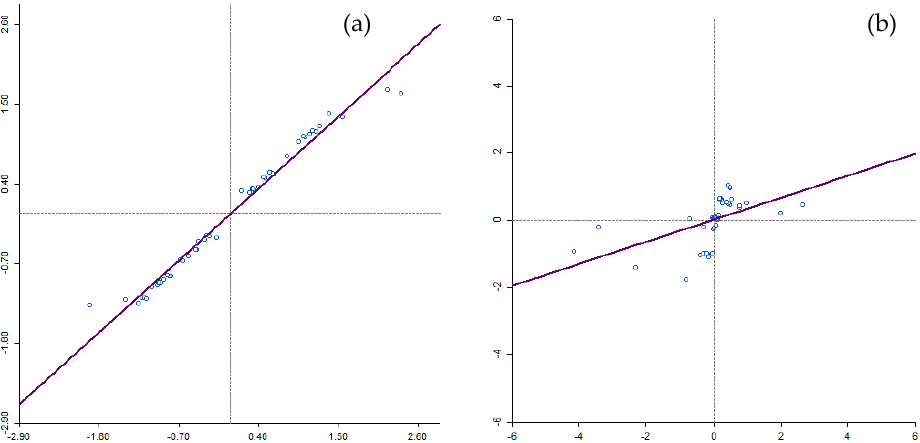
Figure 1. Moran’s I scatter plot for GLRP and GWPR models clustering between HIV/AIDS self- testing uptake and the covariates.